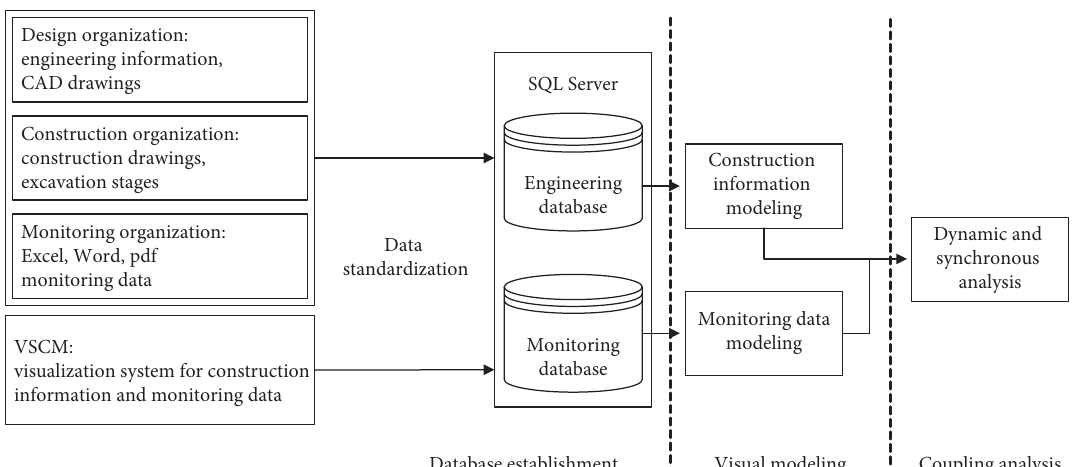
Figure 1: Systematic program scheme design.